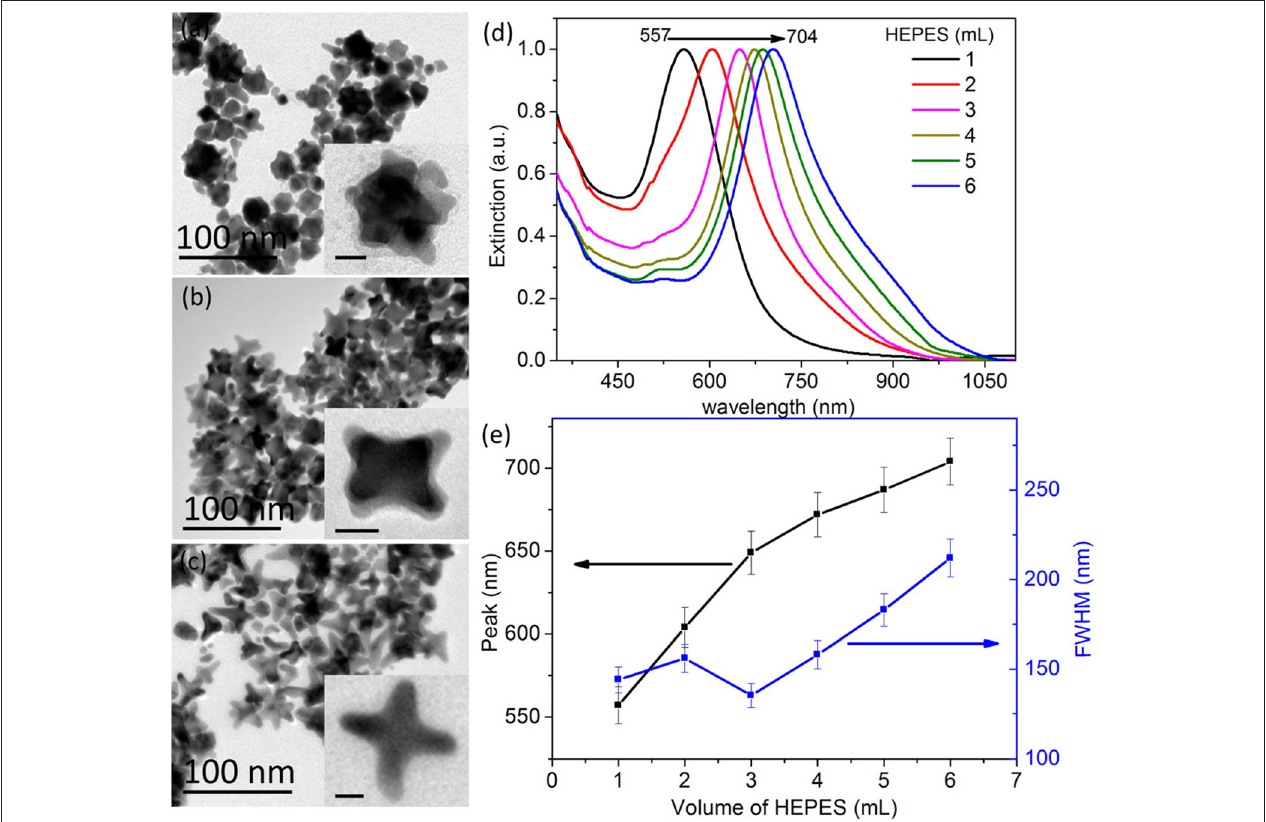
FIGURE 3 | Fabrication of gold nanostars with different shapes. TEM images of gold nanostars prepared at 30 ◦ C are shown in the left panel. The authors were able to create different shapes by adding (a) 1, (b) 3, and (c) 6mL of HEPES solution (0.1M). The scale bar indicates 10nm. (d) Normalized extinction spectra of gold nanostars with different volumes of HEPES. (e) The main extinction peak and FWHM (full width at half-maximum) as a function of HEPES volume. Re-printed with permission from American Chemistry Society Publications 2014 (Liu et al.,